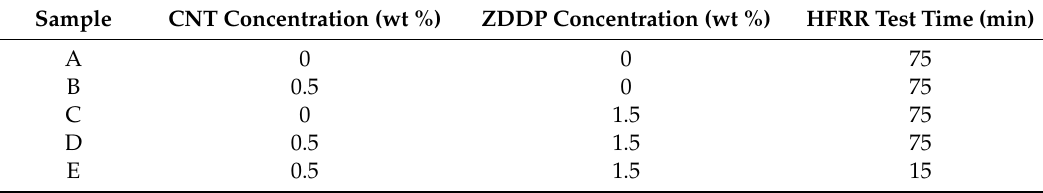
Table 2. Composition of PAO6-based lubricants used to produce samples in the HFRR tests.